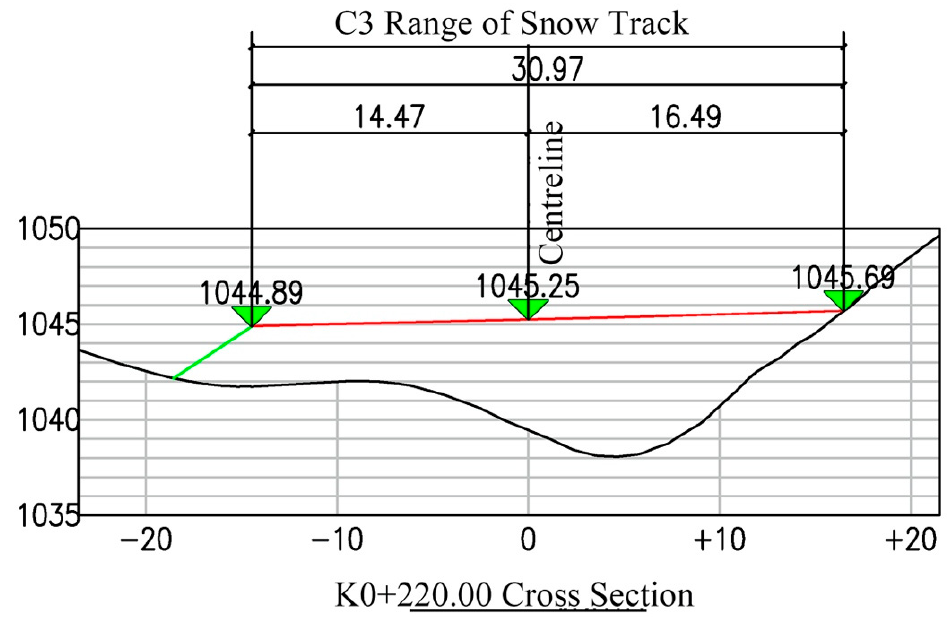
Figure 11. The cross-sectional view of the ski tracks of the National Alpine Ski Center.